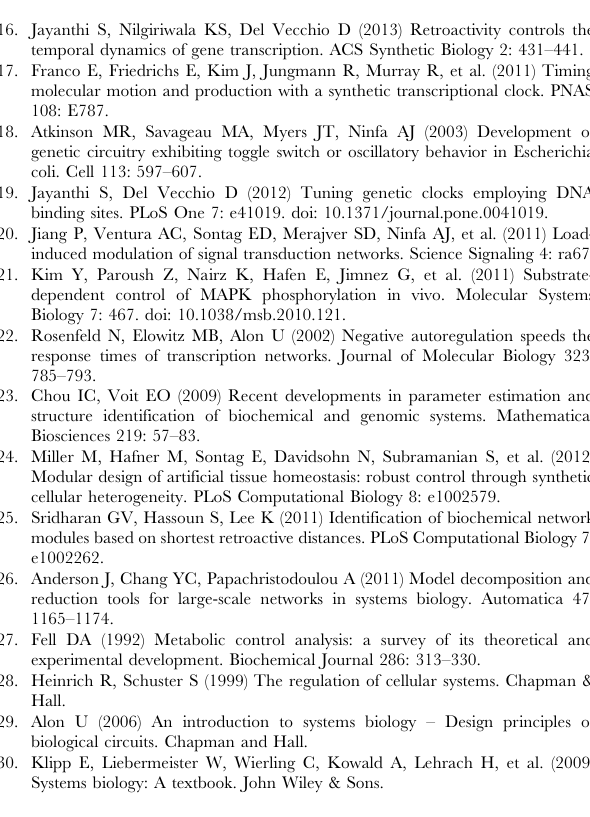
Figure S1 Mixing retroactivity can be avoided by introducing an extra node. Rectangles represent promoter regions, arrows denote coding regions. Promoters are regulated by TFs expressed from coding regions of the same color. (A) The production of (cid:2) xx k is regulated by two TFs: x i from the module,